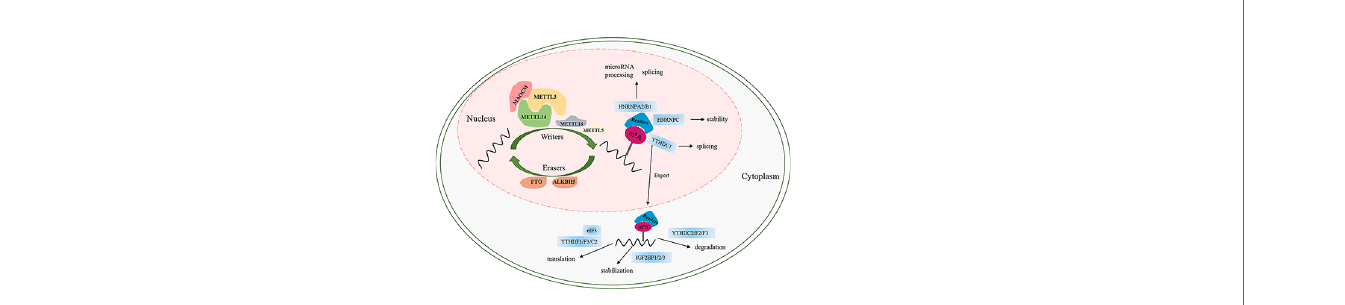
FIGURE 1 | The process of m 6 A modi fi cation. m 6 A RNA methylation is regulated by “ writers ” , “ erasers ” , and “ readers ” . MAOCM, m 6 A-METTL-associated complex, composed of WTAP, VIRMA, RBM15/15B, and